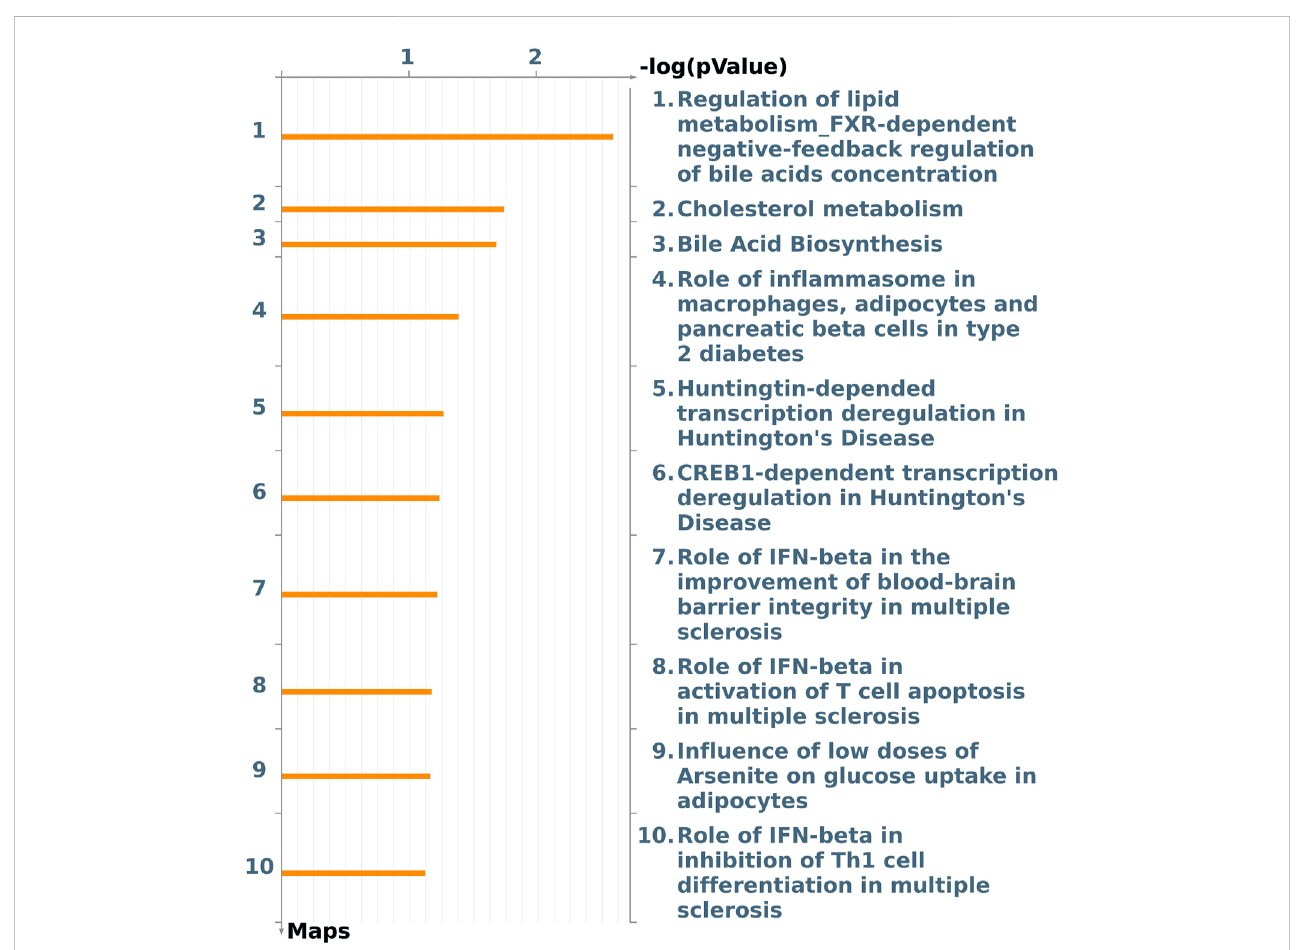
FIGURE 5 Pathwaymapsfromthelistofdifferentiallyexpressedgenes(FDR10%)intheliverofmalepigsfedwithdifferentoilsources(3.0%soybeanoilvs . 3.0% fi sh oil) detected using MetaCore software ( p -value <